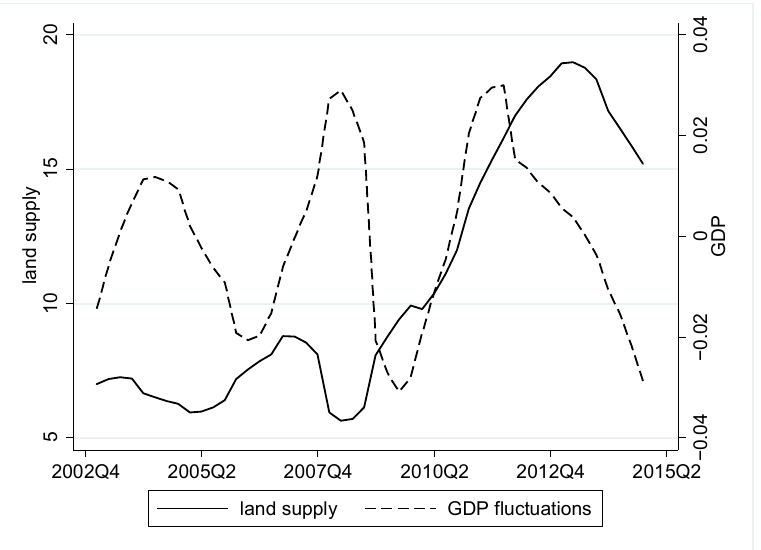
Figure 1. Business cycles of GDP and land supply.